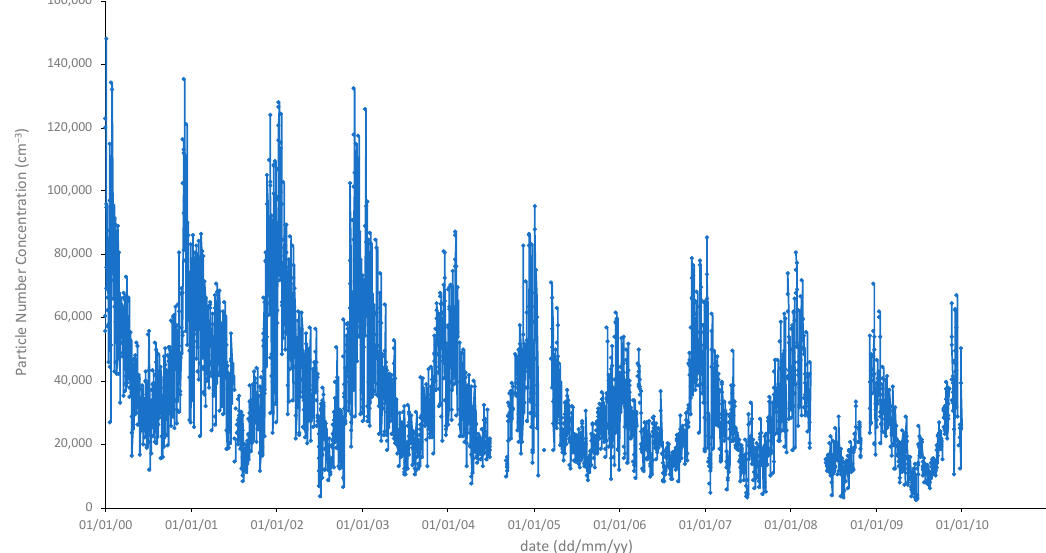
Figure 1. Particle number concentration (PNC) (cm − 3 ) trend during the previous decade. Each point represents a daily value.